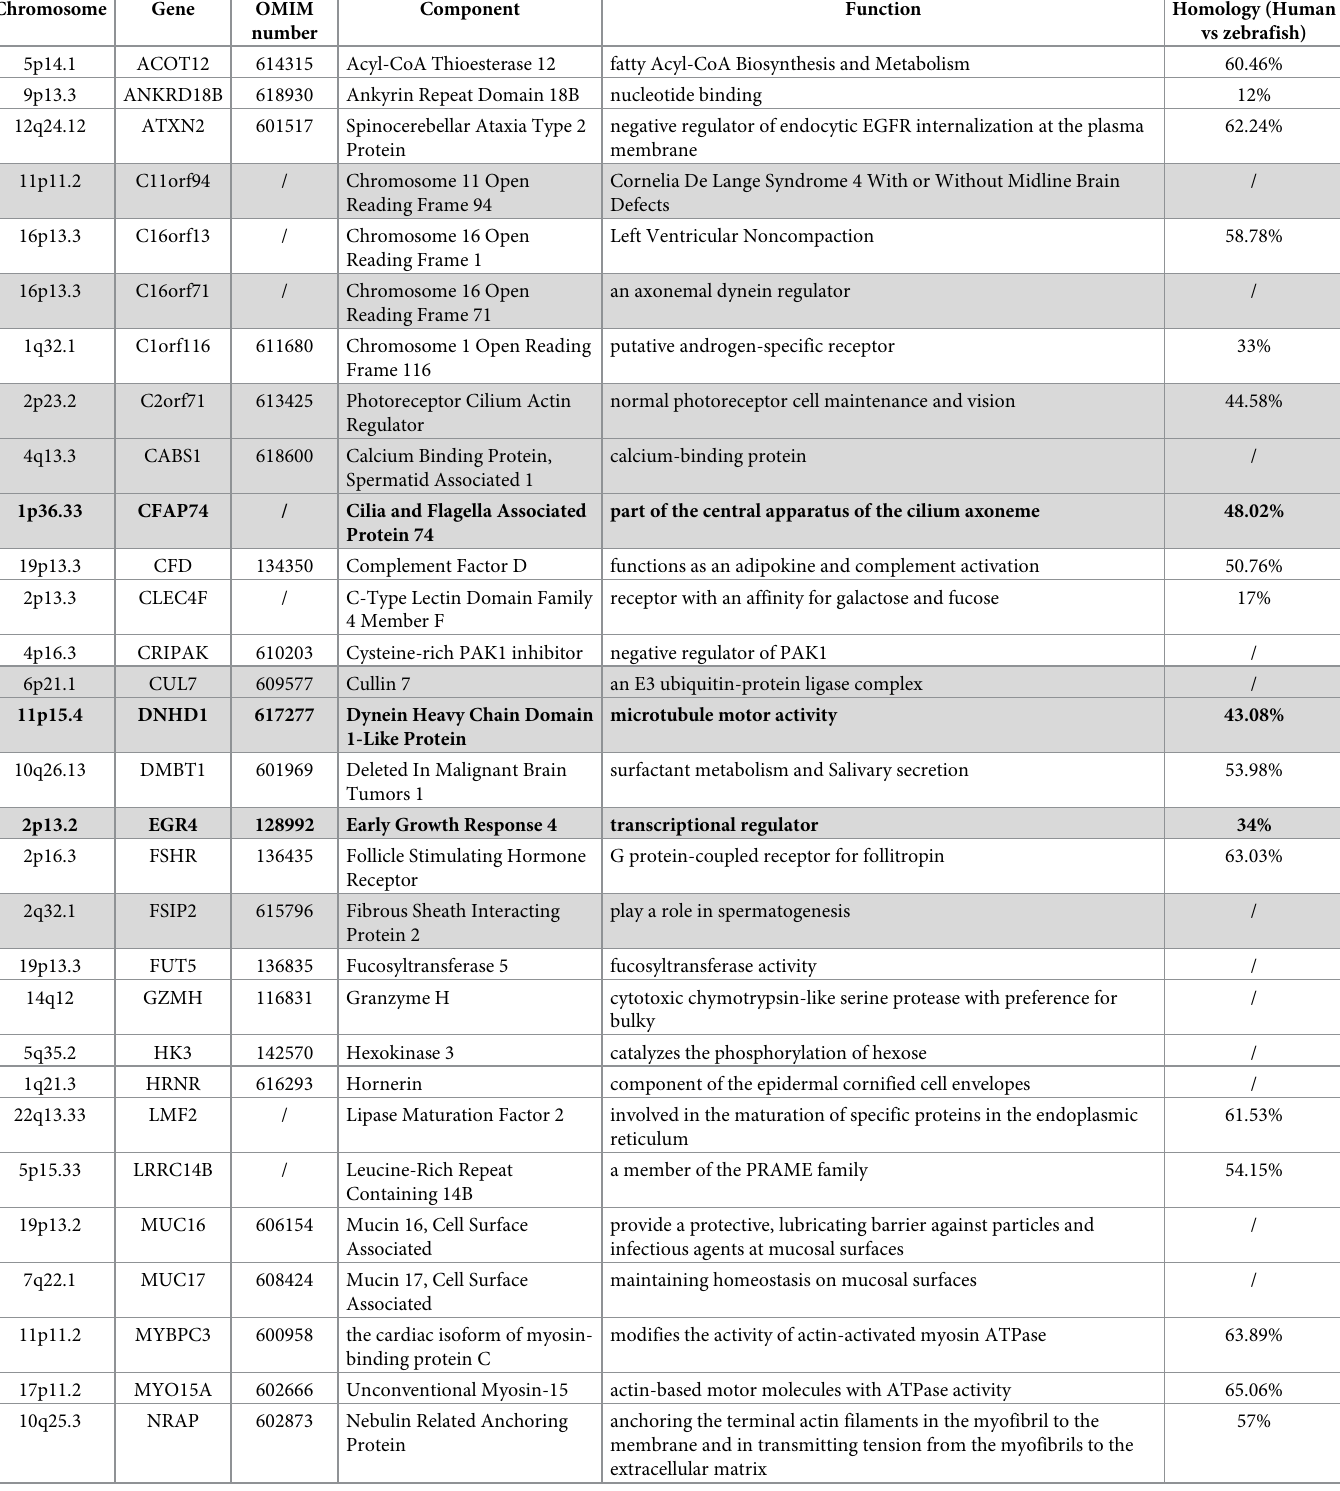
Table 2. The bioinformatics information on the LOF variants of candidate genes.